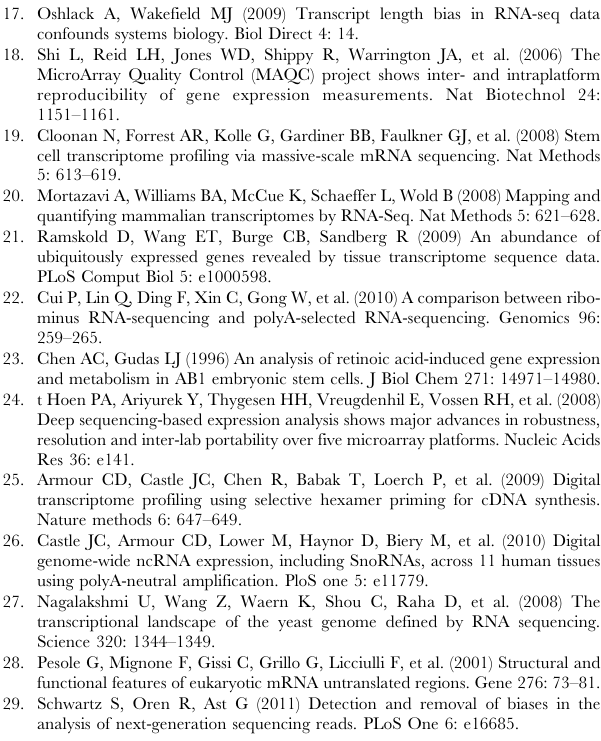
corrected to maximize the number of genes in the bins with